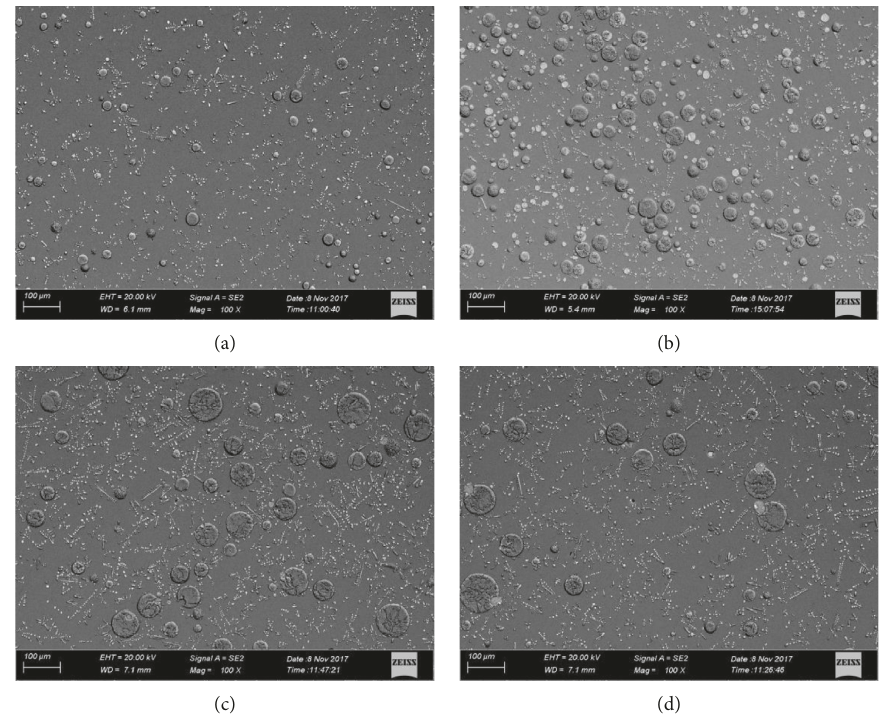
Figure 5: Microstructure of Cu-15 wt.% Fe at different undercooling states at the same magnification of 100 times: (a) ∆ T (b) ∆ T 102K; (c) ∆ T 141 K; (d) ∆ T 159K. (cid:31) (cid:31) (cid:31)